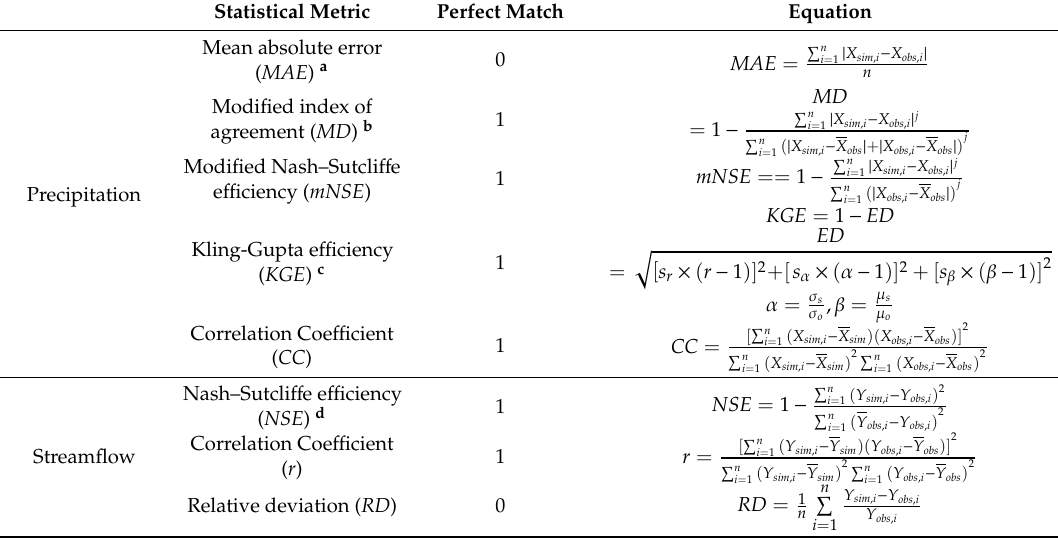
Table 2. Metrics used to evaluate the performance of corrected precipitation series against the reference data